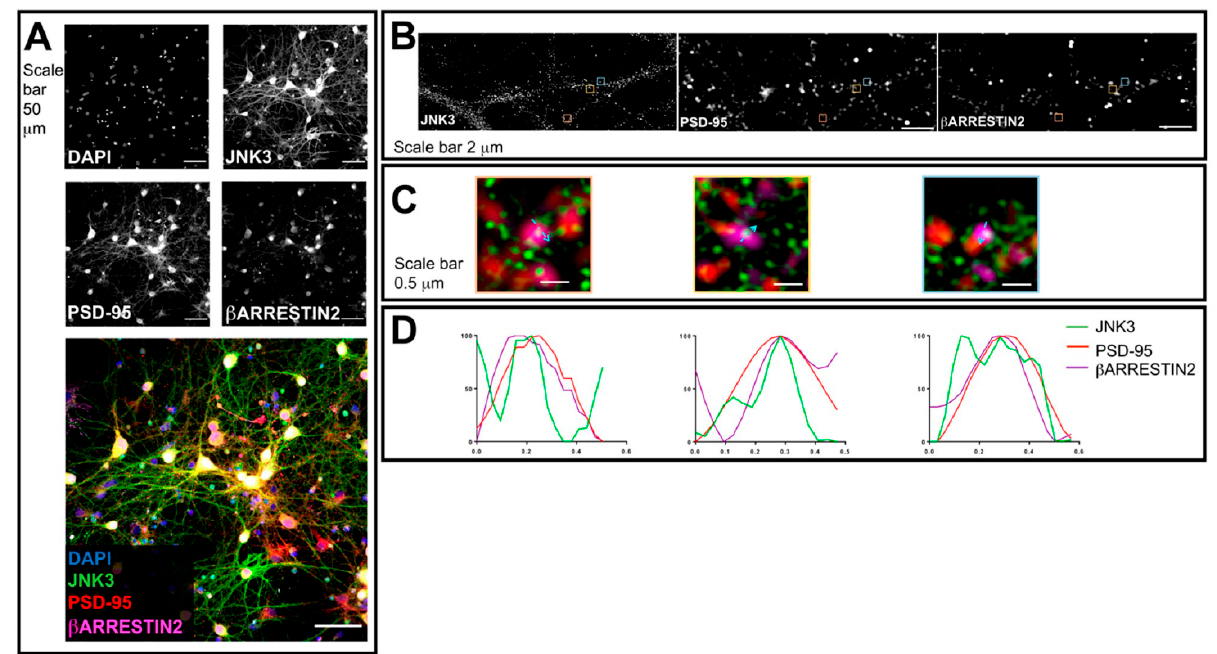
Figure 2. Confocal microscopy and SIM outputs used to assess JNK3– β -arrestin2–PSD95 colocalization. ( A ) Neurons were fixed and stained with anti-JNK3 (green), anti-PSD95 (red), and anti- β -arrestin2 (violet). Images were obtained using a Nikon N-SIM confocal microscope and overlaid to assess protein localization. Nuclei were stained with Hoechst. Scale bar of 50 µ m. ( B ) 3D-SIM images were acquired with a 100 × objective. Scale bar of 2 µ m. Squares represent the location of the inset present in panel ( B ). ( C ) Merged images of reconstructed 3D-SIM images of JNK3 (green), PSD95 (red), and β -arrestin2 (violet). Scale bar of 0.5 µ m. ( D ) The intensity profile (green for JNK3, red for PSD95, violet for β -arrestin2) represents the values indicated by the arrows in panel ( C ). The values are normalized to 100 (arbitrary unit).